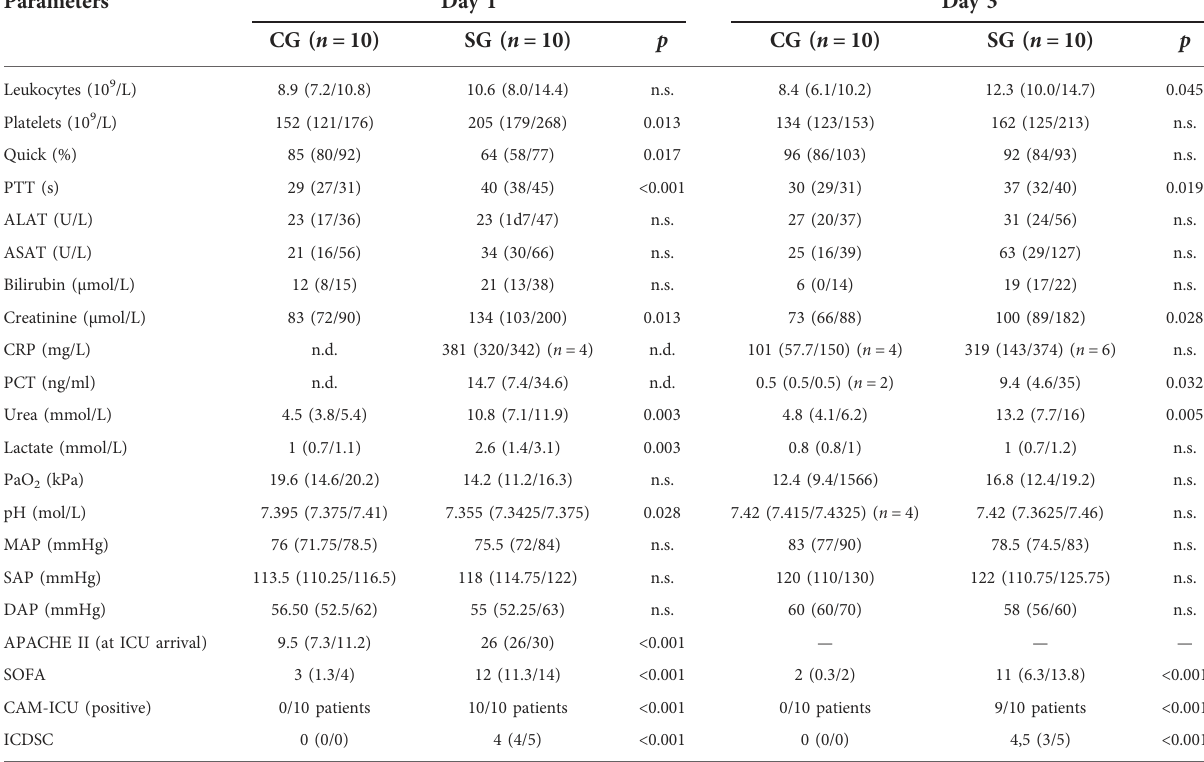
TABLE 1 Results of laboratory parameters, partial oxygen pressure, and scores on days 1 and 3 in the CG and the SG.